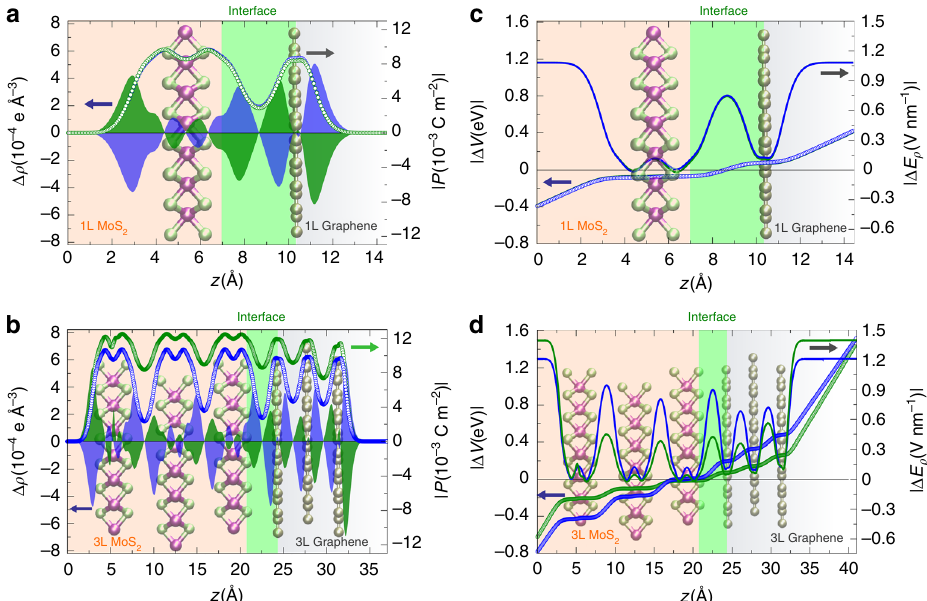
(cid:1) (cid:3) (left y -axis) and electric polarization Fig. 4 Asymmetric dipolar contributions at the MoS 2 /Graphene interface. a , b Induced charge density Δ ρ 10 (cid:3) 4 e Å (cid:3) 3 (cid:4)(cid:5) (cid:5) (cid:5) (cid:5) (right y -axis) for 1L MoS P 10 (cid:3) 3 Cm (cid:3) 2 fi eld is ±1.0 V nm − 1 . Blue (green) 2 /1L Graphene and 3L MoS 2 /3 L Graphene, respectively. The applied electric curves correspond to positive (negative) fi elds. Positive (negative) fi elds go towards graphene (MoS 2 ), and vice versa. The MoS 2 /Graphene interface is highlighted to show the unbalanced formation of electric dipole moments between graphene and MoS 2 accordingly with the number of layer layers used to form the heterostructures. ( c - d ) Difference in electrostatic potential Δ V eV ð Þ ¼ V E ext ≠ 0 ð Þ (cid:3) V E ext ¼ 0 ð Þ in the slabs with and without the external electric (cid:4) (cid:6) fi eld of ±1.0 V nm − 1 , and their corresponding response fi eld Δ E ρ V nm (cid:3) 1 for 1L MoS 2 /1L Graphene and 3L MoS 2 /3L Graphene, respectively. The absolute values of j Δ E ρ j and j Δ V j are taking in ( c ) and ( d ) for comparison at the same side of the plot. Geometries for all systems are highlighted at the background of each panel in opacity